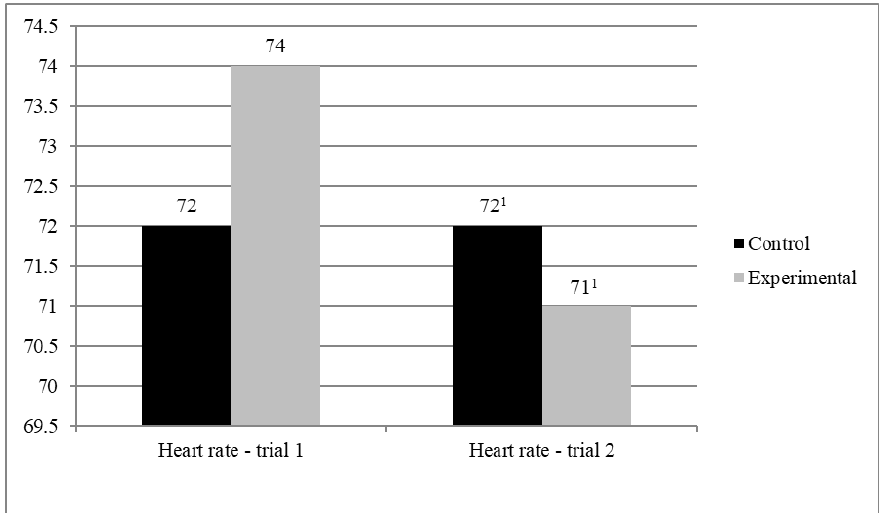
Figure 3. Average heart rate. 1 — in the 2nd trial heart rate in the treatment condition was significantly lower than in the control condition ( p < 0.05)